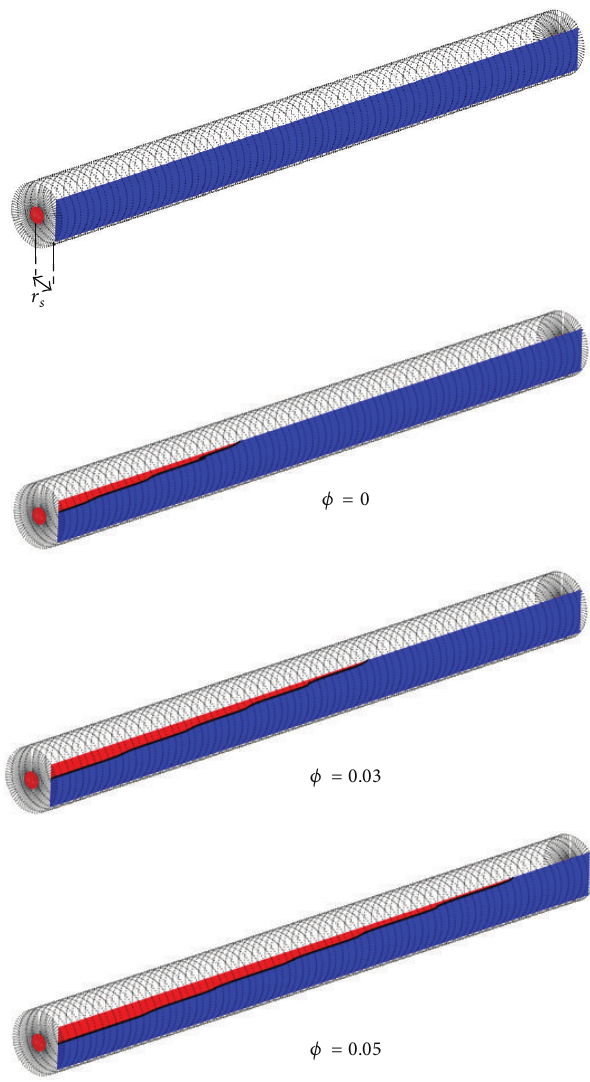
Figure 6: Contour of penetration of front melting in axial direction in 𝑡 = 70